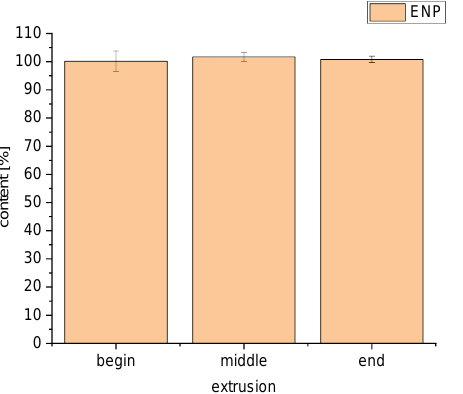
Figure 9. Content uniformity over the entire extrusion for formulation 5 at 70 °C ( n = 10, mean ± SD).